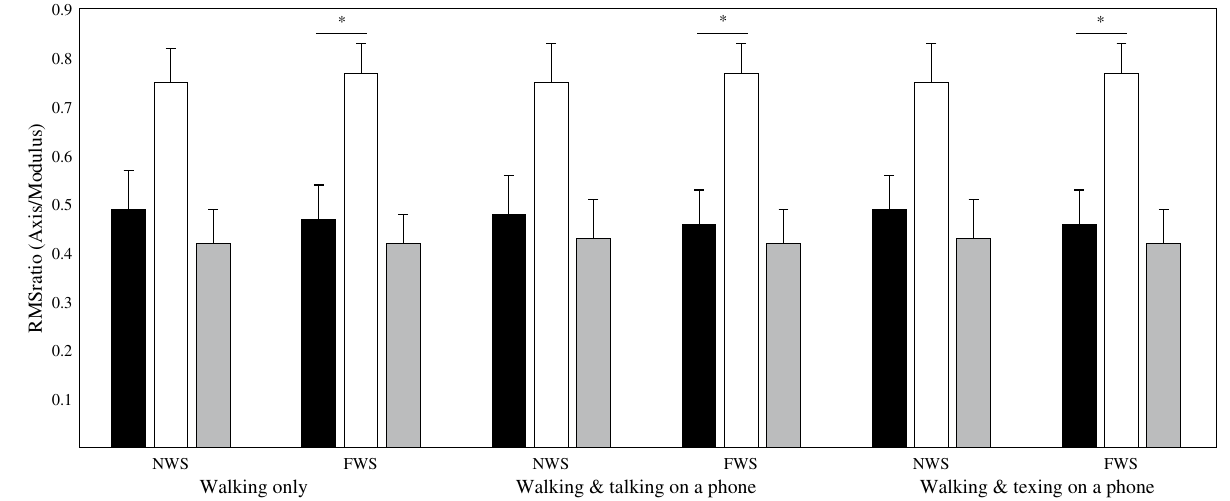
Figure 1. Mean root mean square ratio values when walking at self-selected normal (NWS) and fast walking speed (FWS), while texting on a mobile phone, talking, or performing no concurrent task (walking only). Black bars = anteroposterior axis, White bars = vertical axis, Grey bars = mediolateral axis. ‘*’ denotes a statistically significant effect of walking speed instruction.